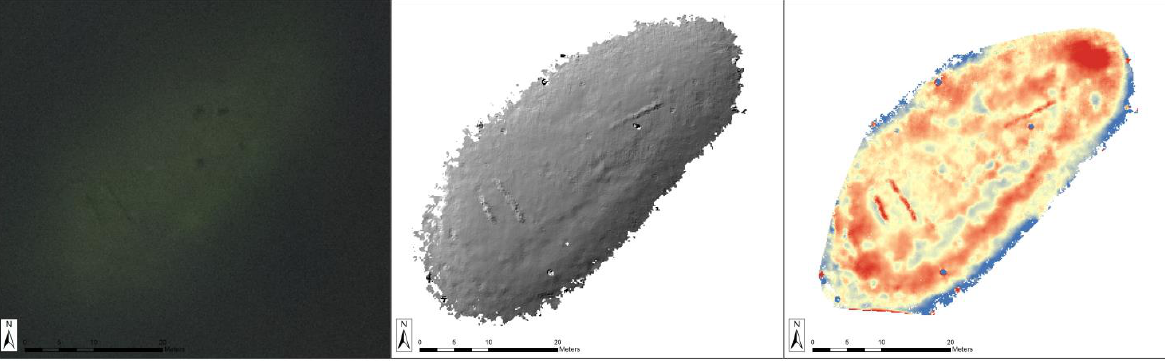
Figure 8. Keutschach, Austria. Traces of a late Neolithic lake dwelling. Left: simultaneously acquired orthophoto; middle: hillshade of ALB derived DTM (light source in upper left corner); right: local relief model of the ALB derived DTM (kernel size = 12.5 m).